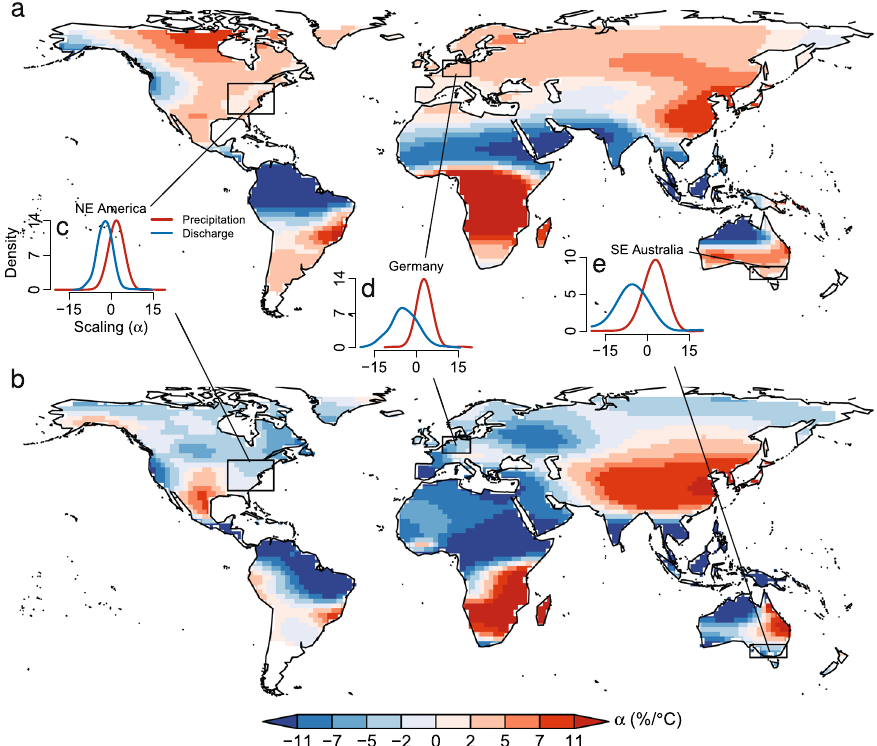
Figure 1. Precipitation and streamflow scaling with temperature for the 99 th percentile. ( a ) Precipitation scaling. ( b ) Streamflow scaling. ( c ) Probability density of scaling coefficients for north east America. ( d ) Probability density of scaling coefficients for Germany. ( e ) Probability density of scaling coefficients for south east Australia. Scaling has been calculated using quantile regression and interpolated using a thin plate smoothing spline. This figure was created using the ‘maps’ 59 and ‘mapdata’ 60 packages in the statistical software ‘R’ 61